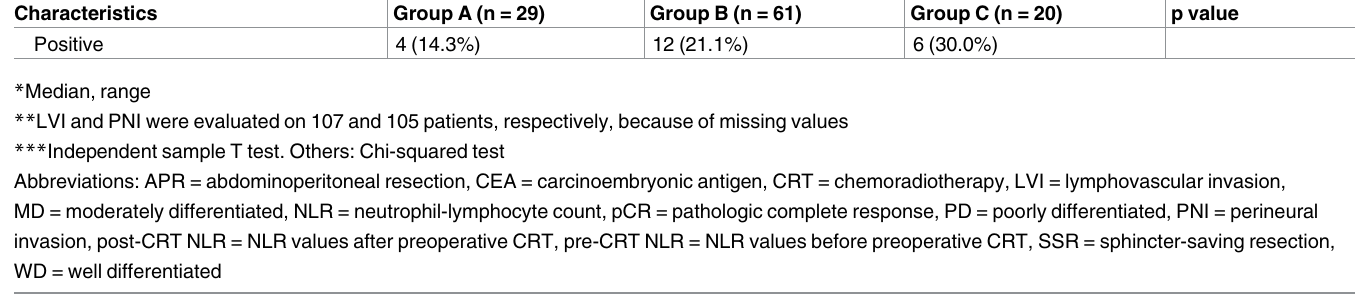
Table 3. Multivariate analysis revealed that NLR group and pre-CRT CEA were significant